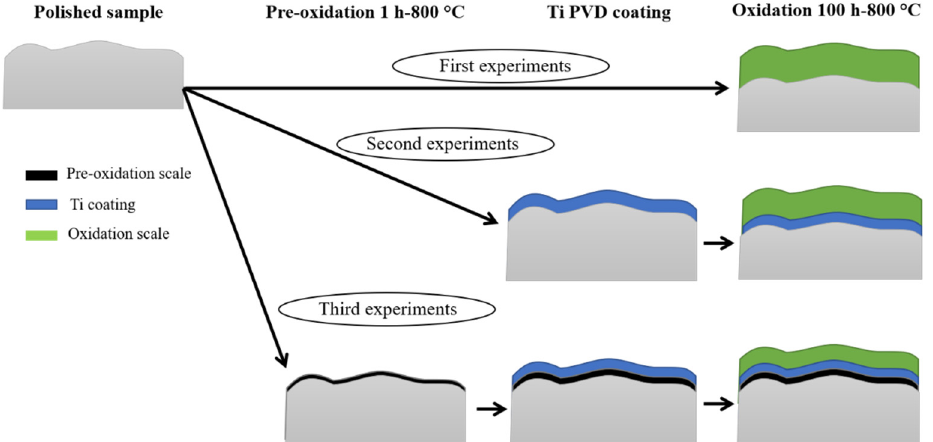
Figure 1. Schematic approach of the experimental study.